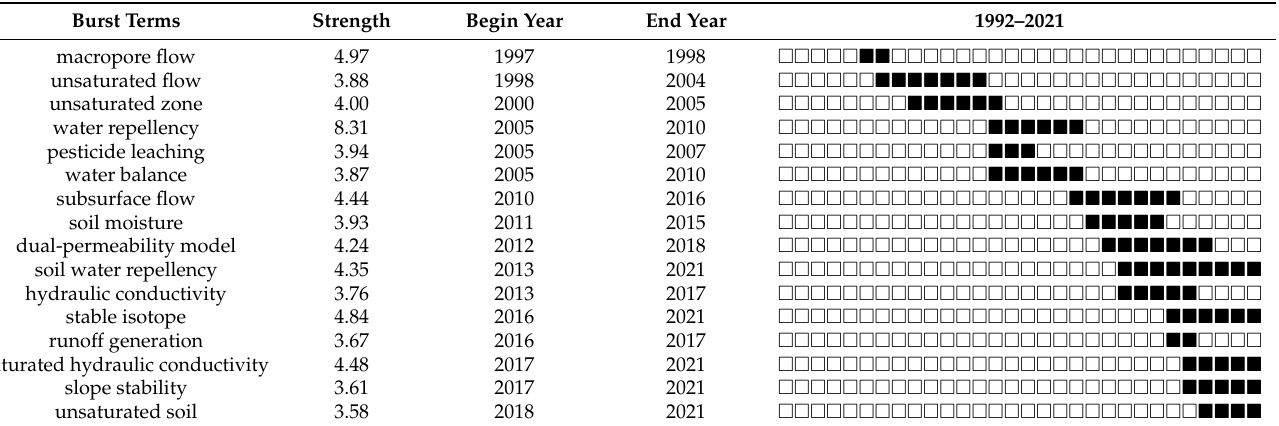
Table 5. Analysis of burst terms from WoS